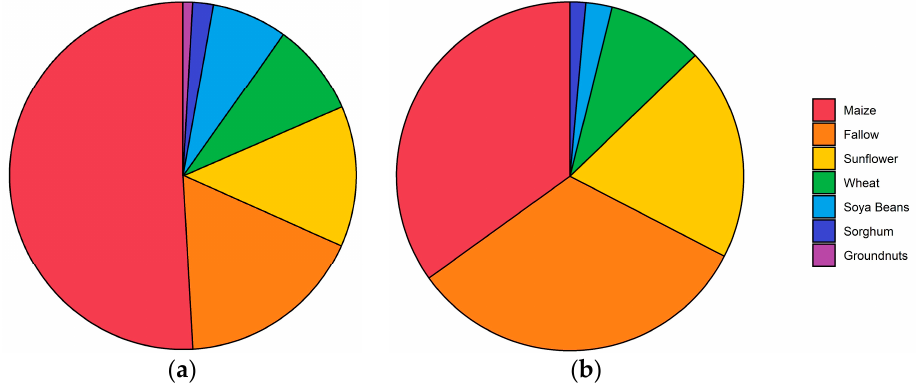
Figure 1. The land use in the Free State on average from 2006 to 2017 ( a ) and during the drought year of 2015–2016 ( b ). Data provided by the South African Department of Agriculture, Fisheries and Forestry (DAFF).